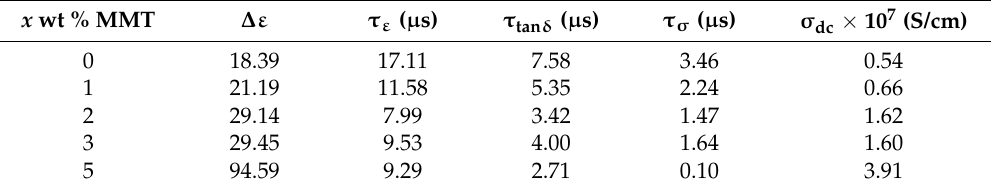
Table 5. Values of real part of permittivity ε ’ at 1 kHz and 1 MHz, dielectric relaxation strength Δε = ε ’ (1 kHz) − ε ’ (1 MHz), dielectric relaxation time τ ε , loss tangent relaxation time τ tan δ , conductivity relaxation time τ σ , and DC ionic conductivity σ dc of ball mill blended solution-cast electrolyte films PEO–LiClO 4 (EO:Li + = 20)– x wt % MMT. Adapted from Choudhary [150]. Copyright, 2013, National Institute of Science Communication and Information Resources (NISCAIR).